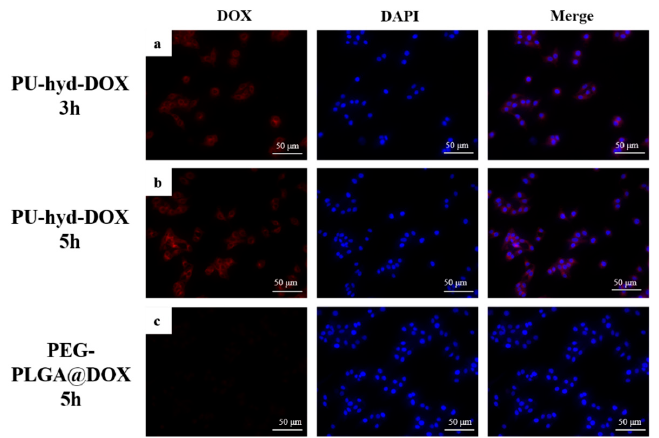
Figure 6. The fluorescent microscopy images of the different incubation times of HepG2 cells with PEG-PLGA@DOX and PU-hyd-DOX micelles at pH 7.4; ( a ) PU-hyd-DOX 3 h ( b ) PU-hyd-DOX 5 h ( c ) PEG-PLGA@DOX 5 h